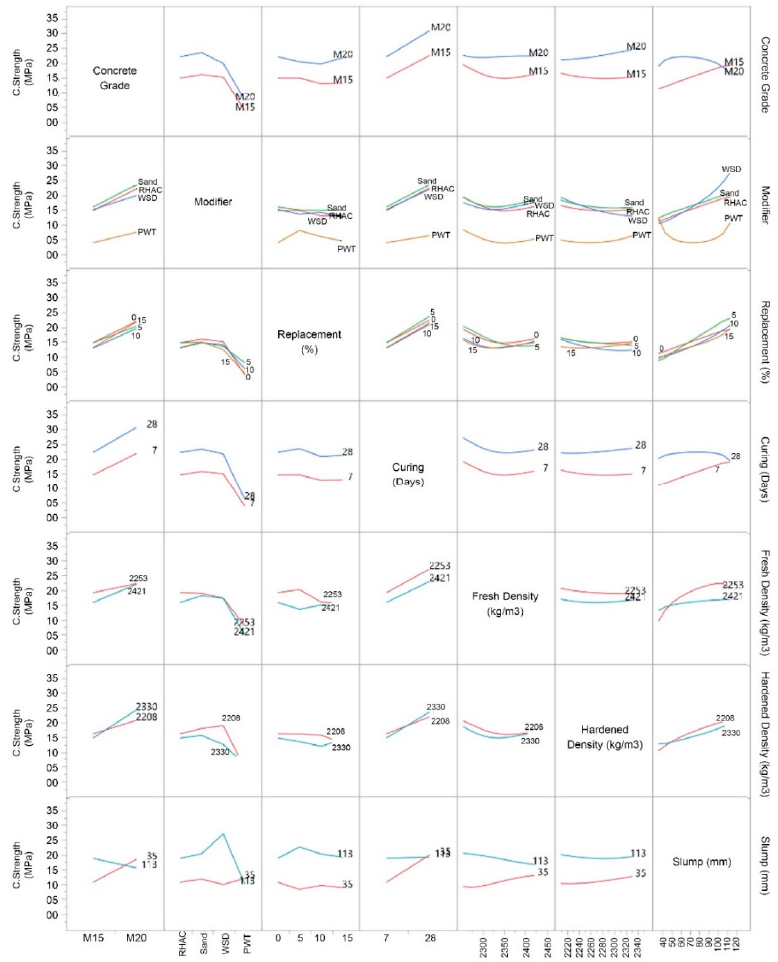
Figure 10. Compressive strength interaction profile.